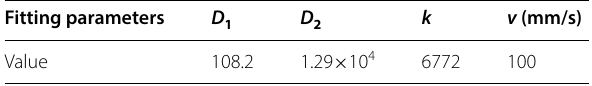
Table 4 Equation parameter setting of Eq. (15) Fitting